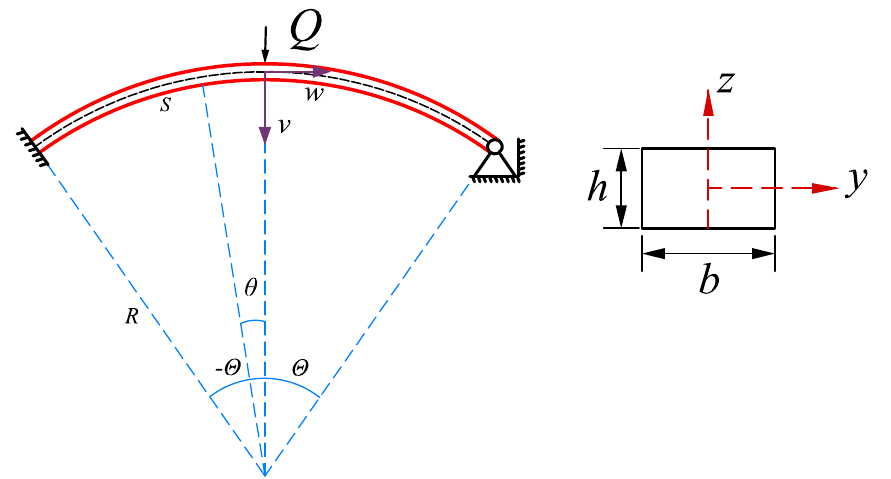
Figure 2. Schematic configuration of the functionally graded graphene nanoplatelet-reinforced composite (FG-GPLRC) arch.